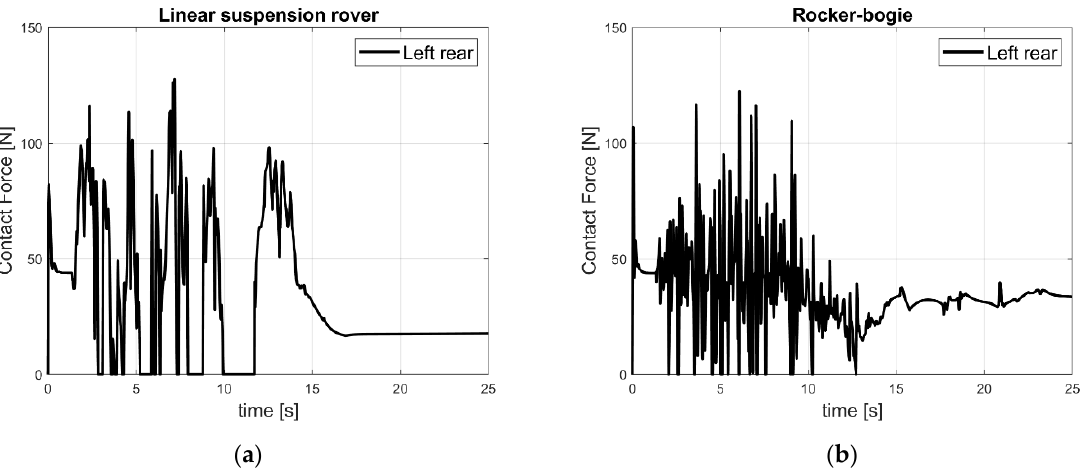
Figure 10. Contact force between the wheel and ground for the left rear wheel: ( a ) LSR; ( b ) RBR.